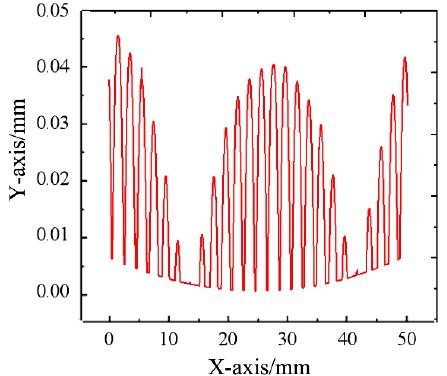
Figure 9. Off-axis trajectory of